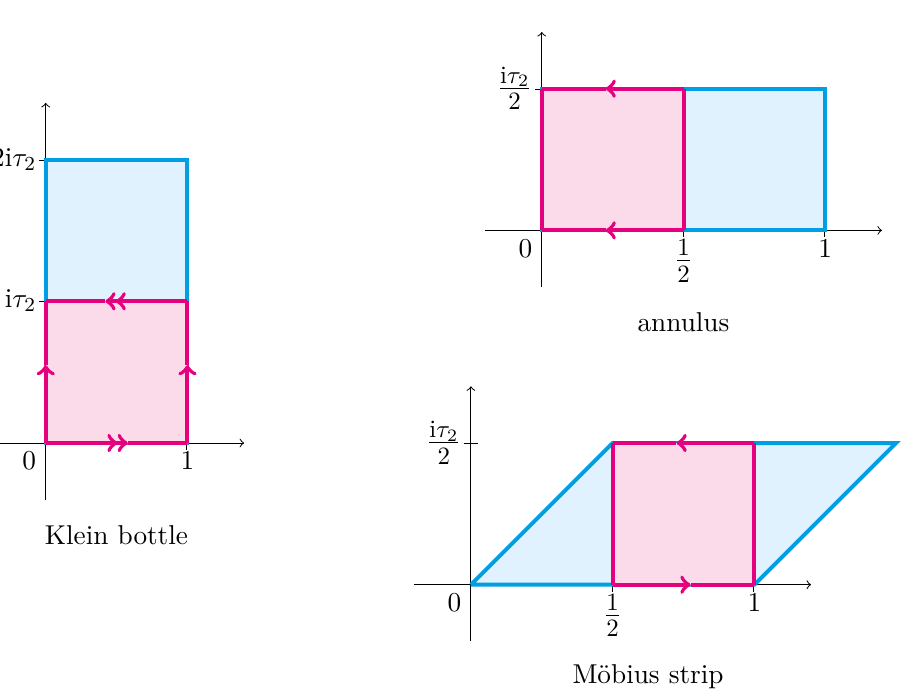
Figure 3 . A sketch of the fundamental polygons (magenta) and of the double-covering tori (cyan) for the Klein bottle, the annulus and the Möbius strip in the complex plane. Any point z ∈ C can be mapped into the fundamental polygon by means of a combination of the corresponding antiholomorphic involution and of the lattice symmetry of the associated double-covering